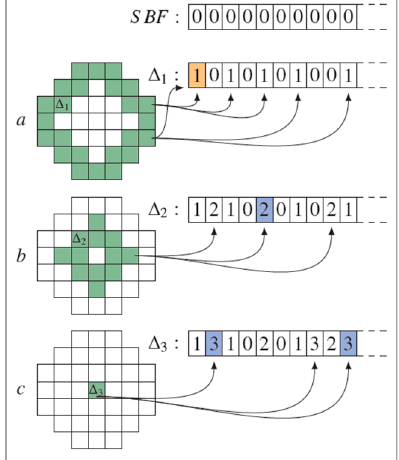
Figure 1. Spatial bloom filter (SBF). ( a ) Two BF elements joined to ∆ 1 are processed through the use of the hash functions, leading to six one-value elements that can then be written into the SBF. The same method can be used in ( b ) and ( c ).